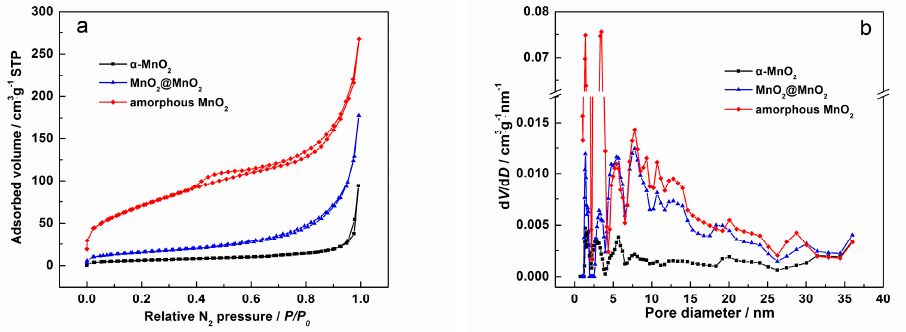
Figure 4. N 2 adsorption-desorption isotherms ( a ) and the pore size distribution ( b ) of α -MnO 2 , MnO 2 @MnO 2 and amorphous MnO 2 .